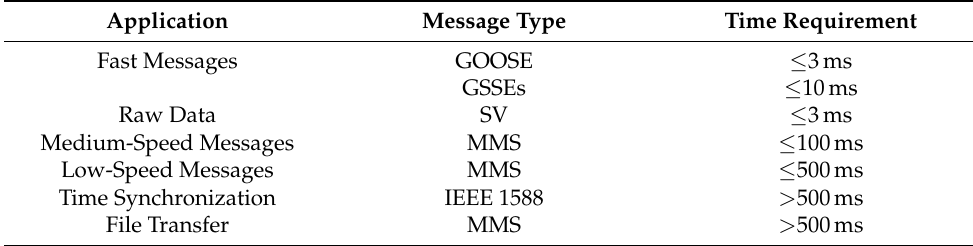
Table 2. IEC 61850 time requirements